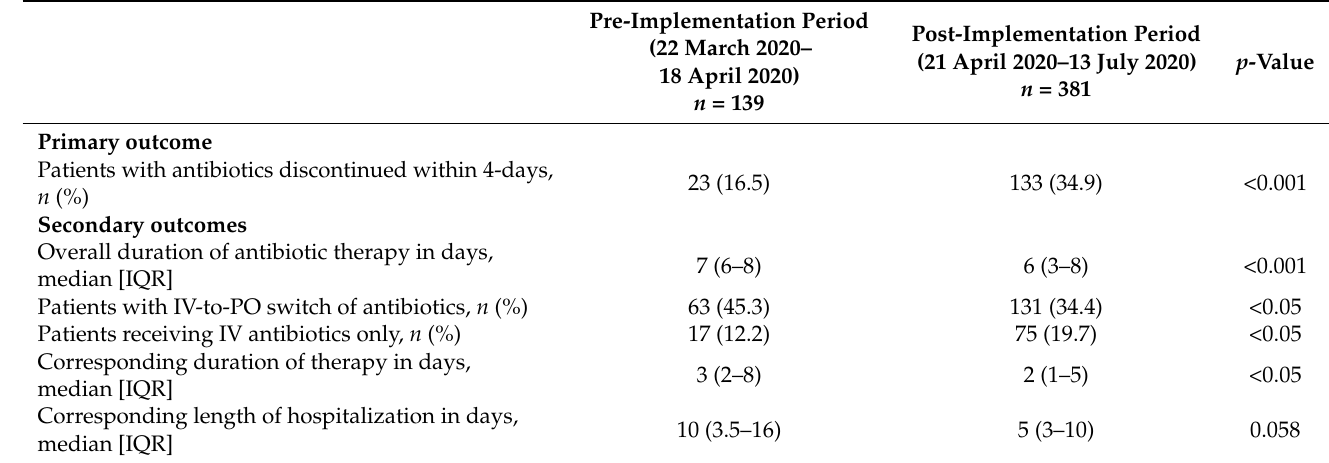
Table 2. Primary and secondary outcomes of the